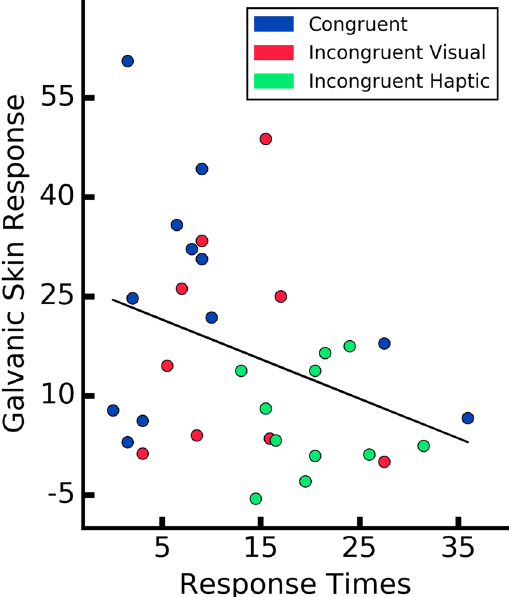
Figure 8. Correlation between the performance measure (mean RTs from the last five trials for each participant) and post-threatening galvanic skin response signal (mean GSR signal after the first peak). Every data point represents a